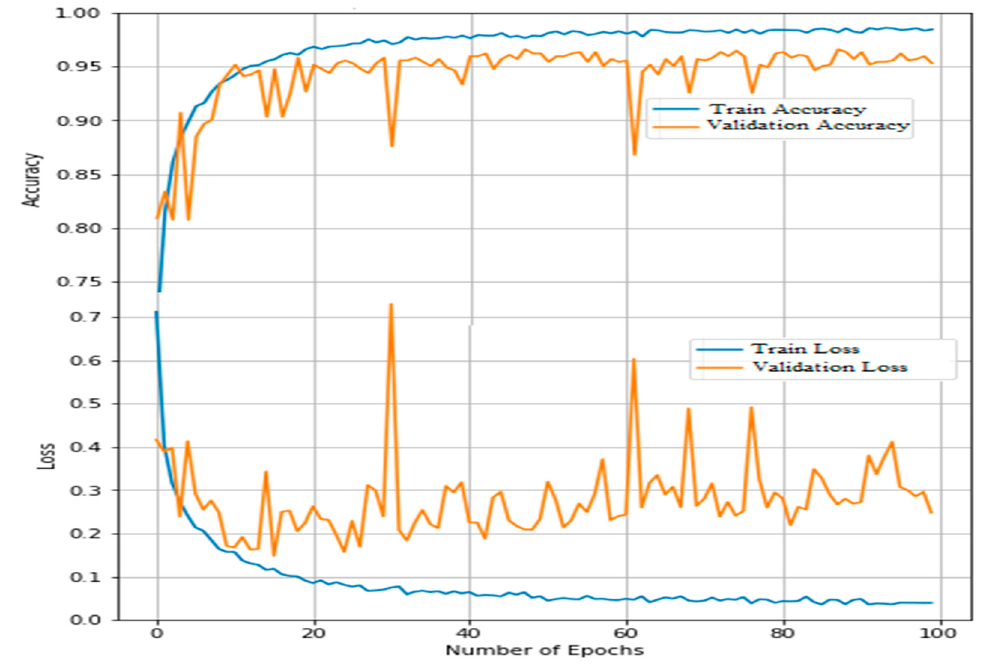
Figure 4. Loss and accuracy results of training and validation over 100 epochs.